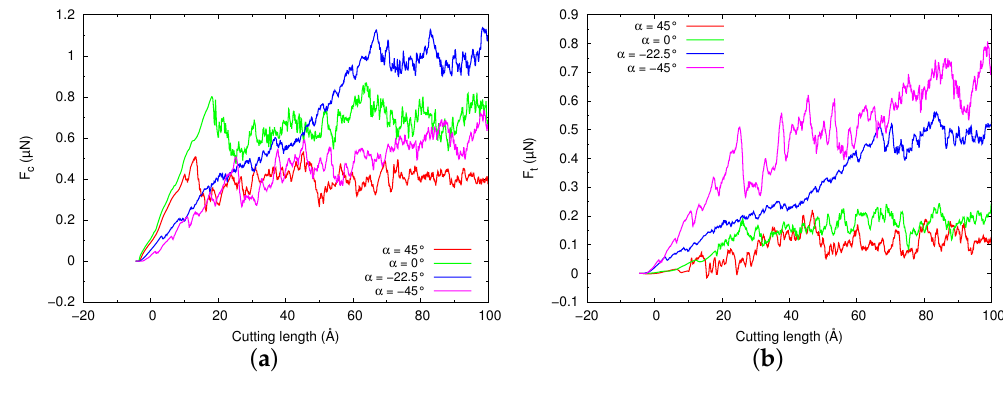
Figure 7. ( a ) Cutting force, F c , and ( b ) thrust force, F t , as a function of the cutting length L .